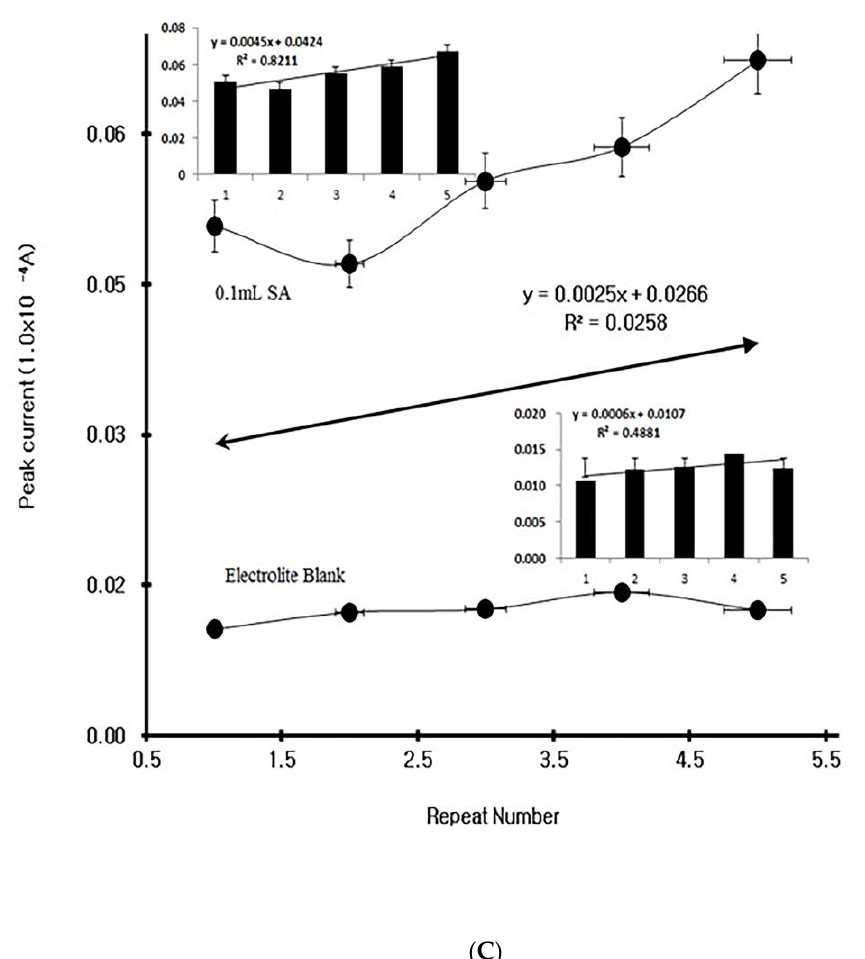
Figure 2. ( A ) Analytical working variations for the 0.5-, 1.0-, 1.5-, 2.0-, 2.5-, 3.0-, and 3.5-ul SA add in 1-mL serum using the MCN working electrode for CV - ○ - and SW - ● -. ( B ) SW accumulation time variation for 30, 60, 80, 120, 150, 180, 210, and 240 s - ● -, and SW accumulation potential variation for −2 .0, −1 .8, −1 ,6, −1 .4, −1 .2, −1 .0, −0 .8, and −0 .6 V - ○ -. ( C ) Statistic MCN probe stability in serum blank and SA spike. Other parameters were used for the optimum conditions.